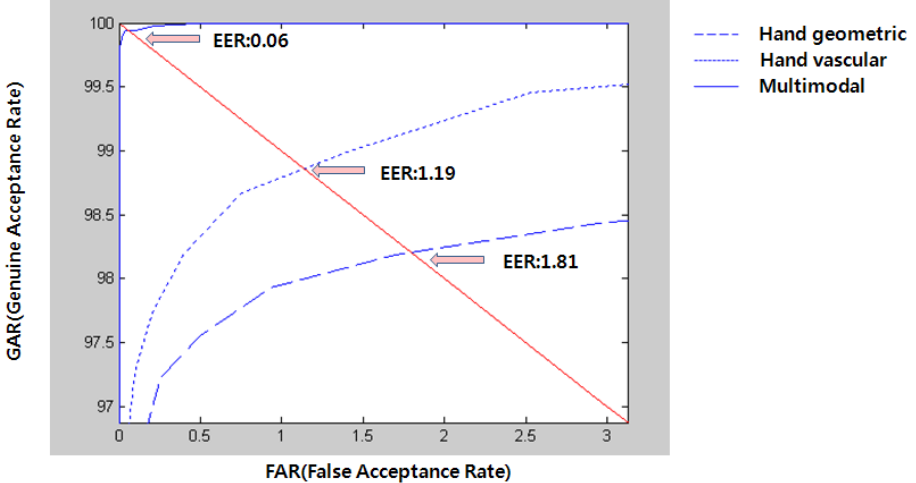
Figure 15. ROC curves of unimodal and multimodal biometrics.